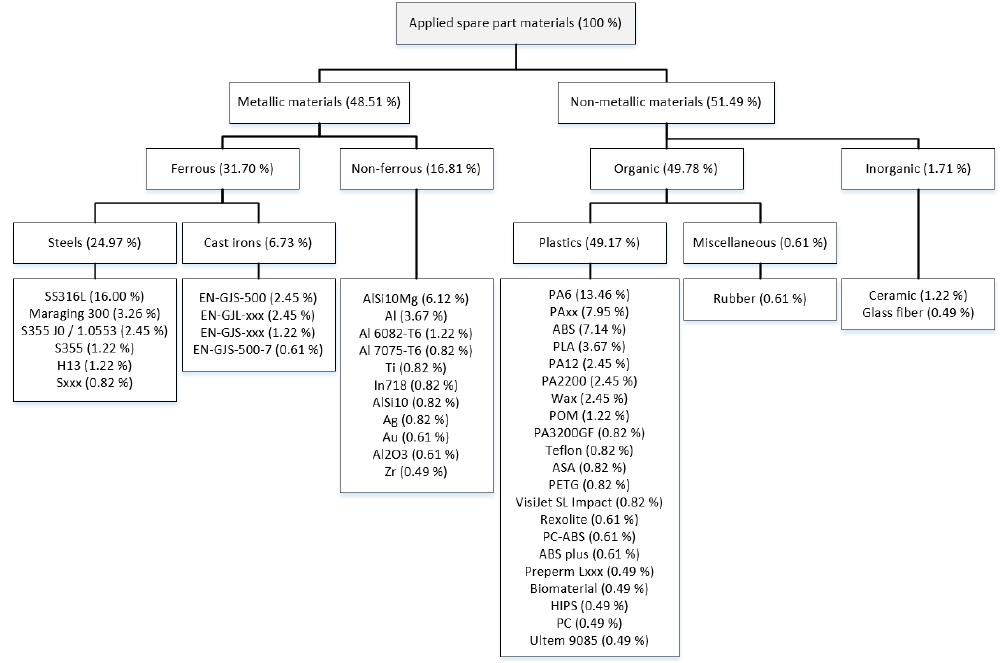
Figure 2. Applied spare part materials.